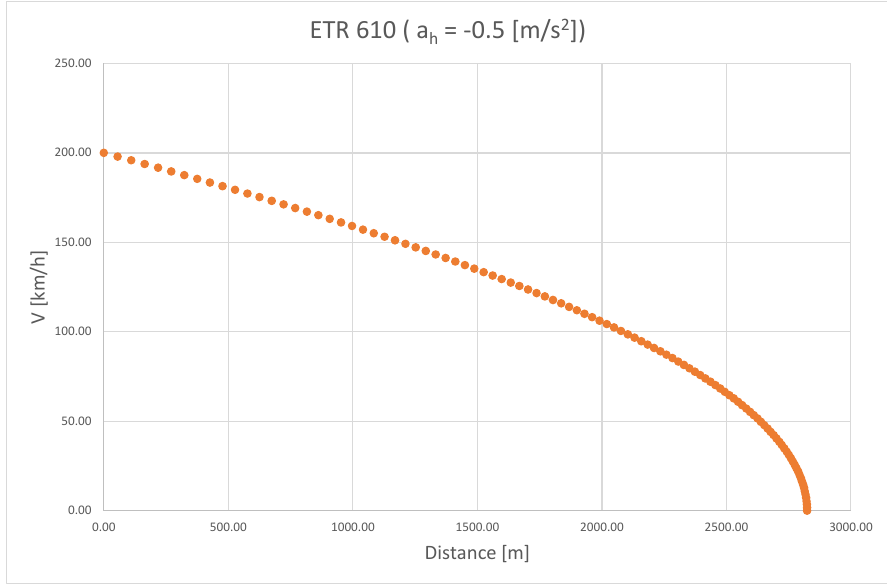
Figure 4. Braking characteristics of the ETR610 (ED250) service train.